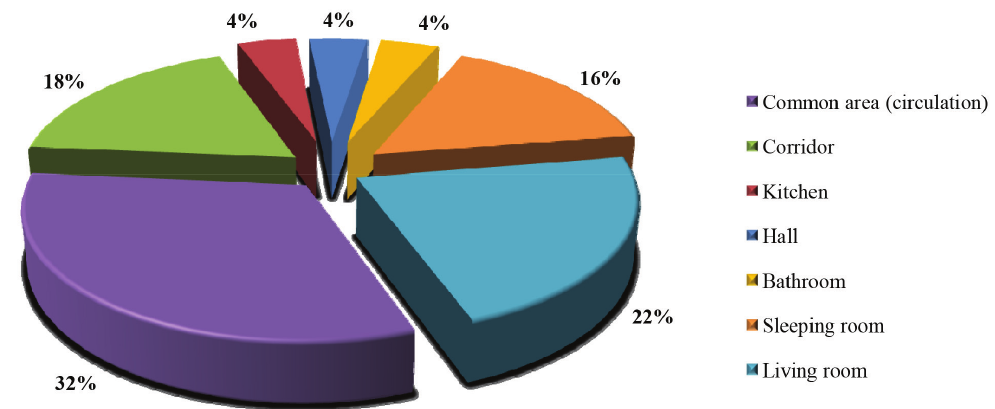
Fig. 1. Characterisation of the sample by type of interior